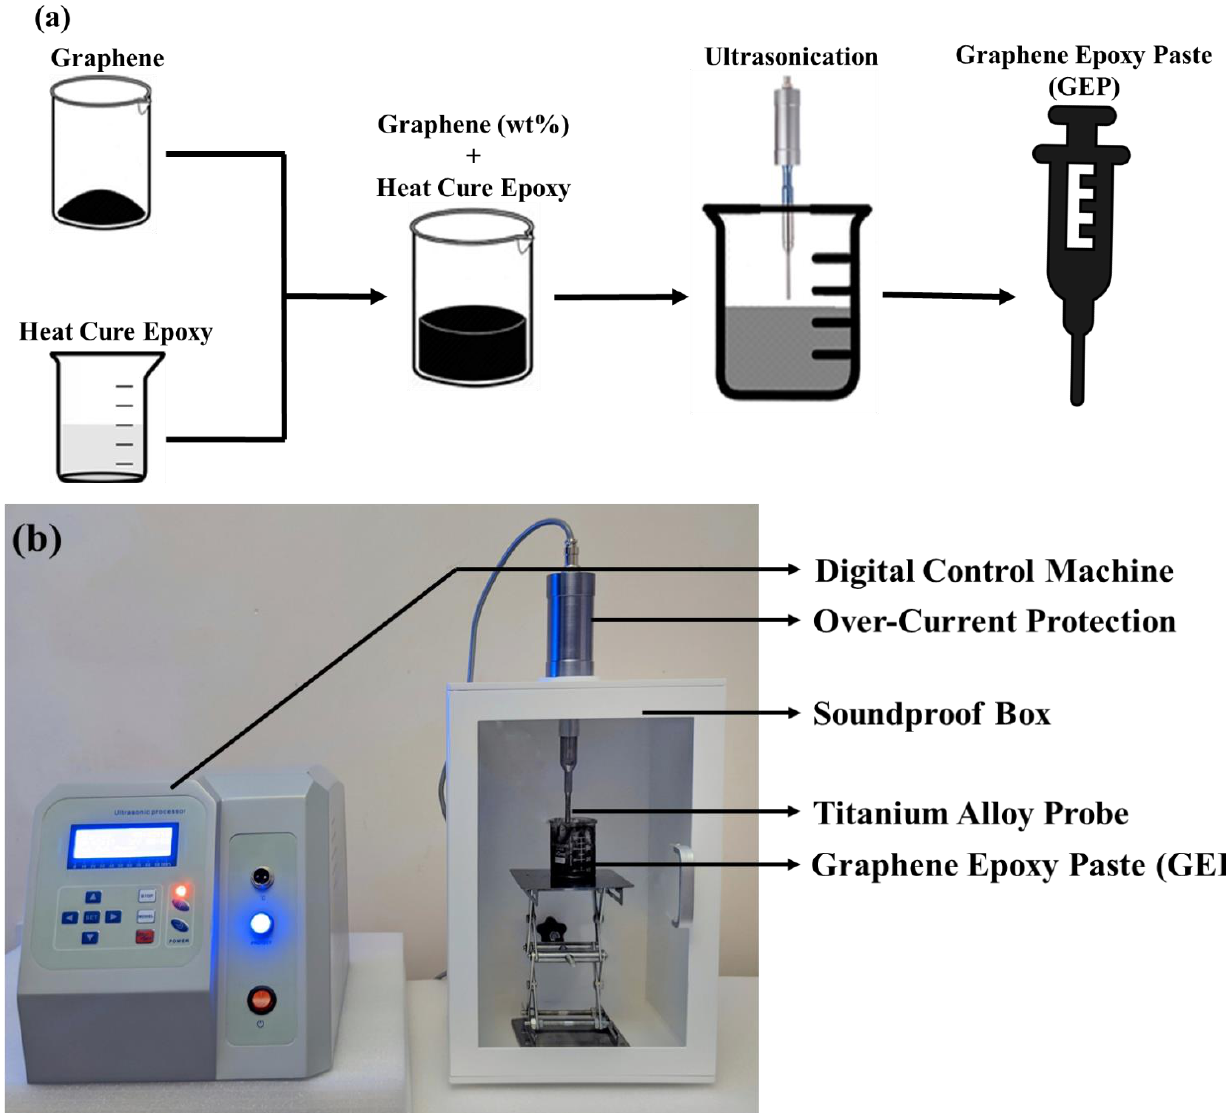
Figure 4. Preparation of graphene epoxy paste: ( a ) Steps involved in preparation of GEP; ( b )ultra- sonic processor.